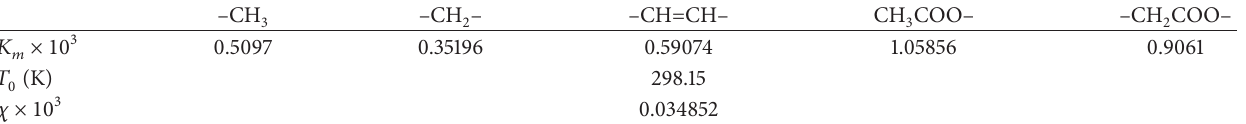
Table 1: Group contribution values for molecular compressibility estimation at atmospheric pressure